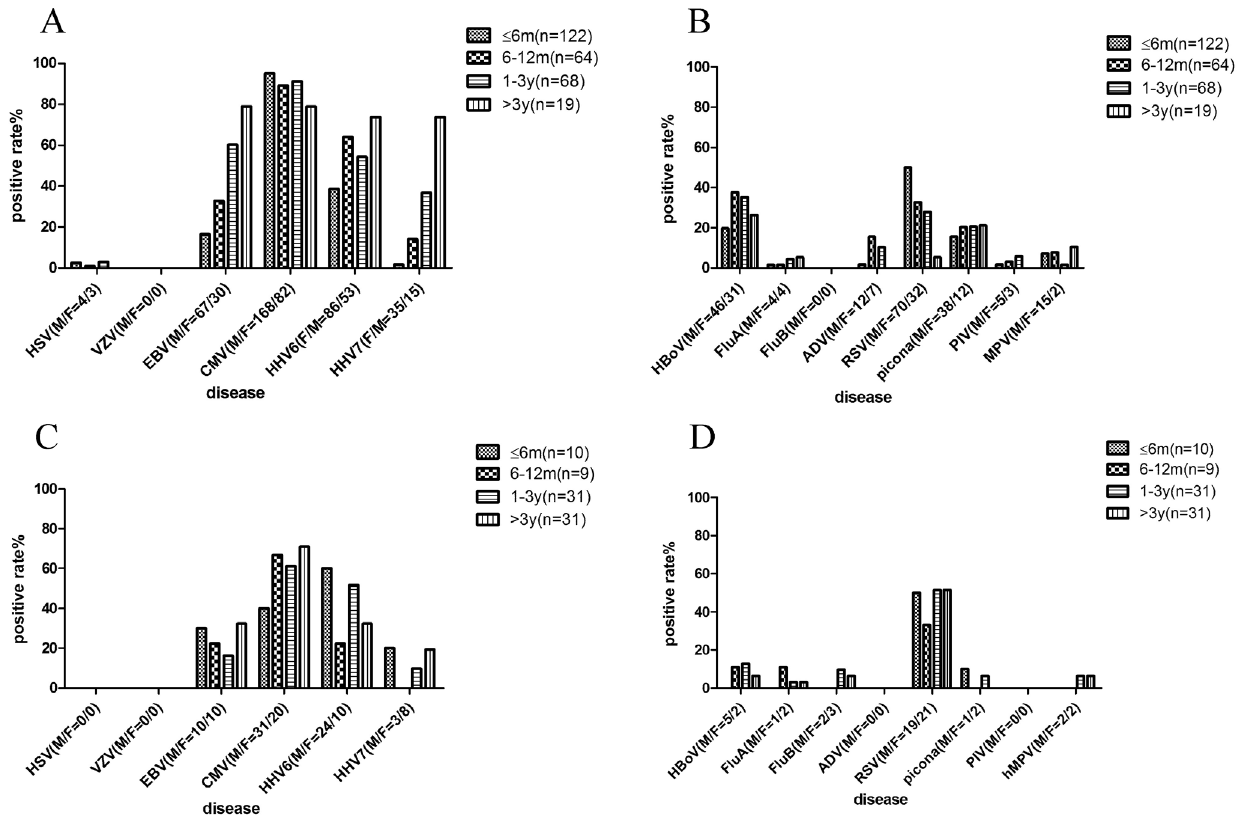
Figure 1. Distribution of viruses among different age groups in this study. (A) Detection HHVs in CAP group; (B) Detection common respiratory viruses in CAP group; (C) Detection of HHVs in non-CAP group; (D) Detection common respiratory viruses in non-CAP group.